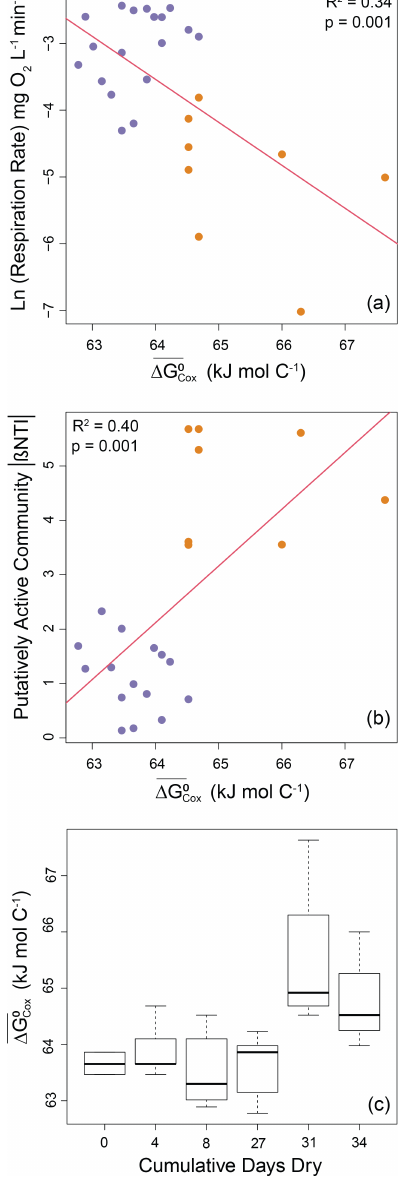
Figure 5. Microbial processes and properties as a function of OM thermodynamics as well as impacts of disturbance on OM thermo- dynamics. (a) Respiration rates (natural log transformed) decreased with decreasing favorability for oxidation (larger values of (cid:49)G 0 (b) The strength of deterministic selection measured as the absolute value of β NTI increased with decreasing favorability for oxidation. Regression models are shown as red lines, and statistics are pro- vided on each panel. (c) Boxplot representations of the distributions of OM thermodynamics across experimental treatments. Significant increases were observed for treatments with 31 or 34 cumulative dry days. See text and Fig. S7 for a description of statistics. Treatments with 0, 4, 8, or 27d dry are shown in purple. Treatments with 31 or 34d dry are shown in